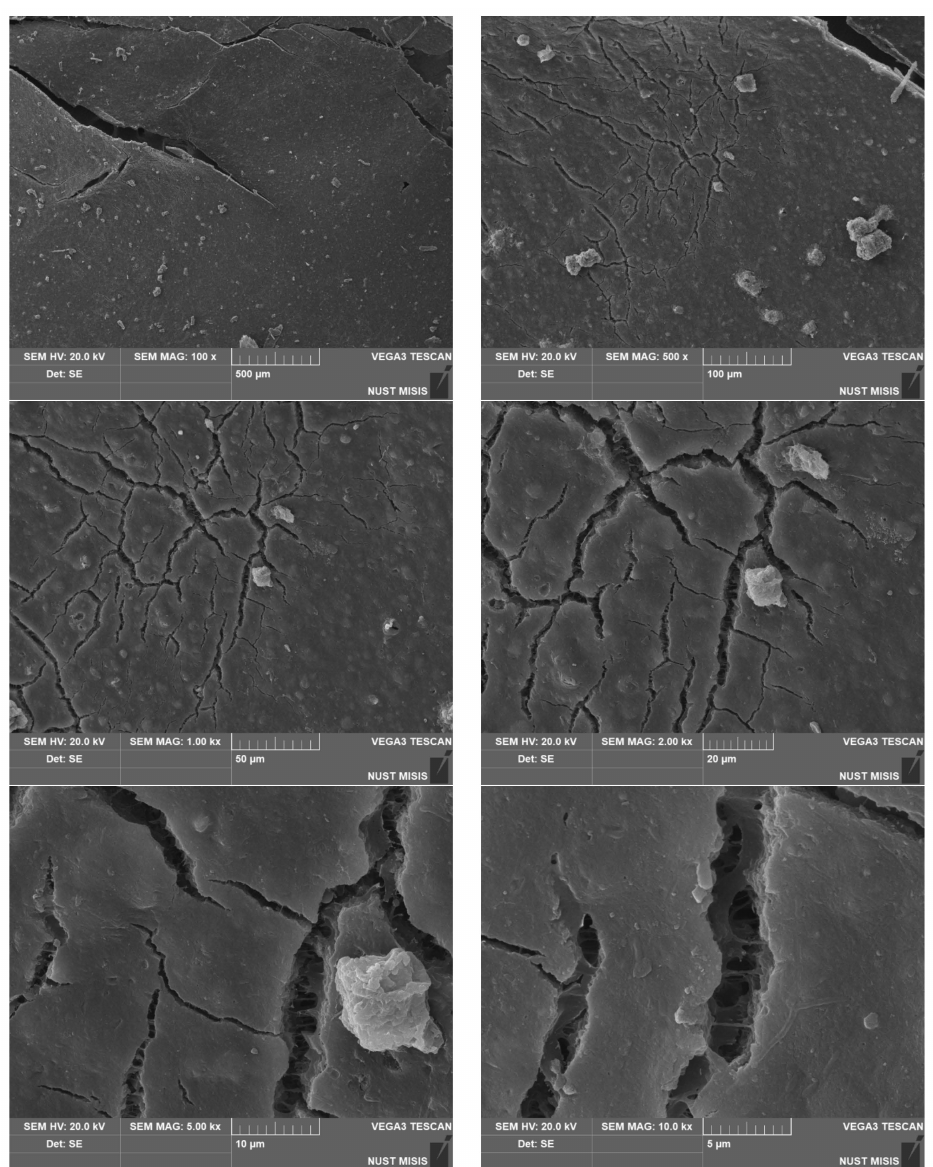
Polymers 2023 , 15 , x FOR PEER REVIEW Figure 11. SEM images of the PLA/PBAT film surface after composting for 180 days.